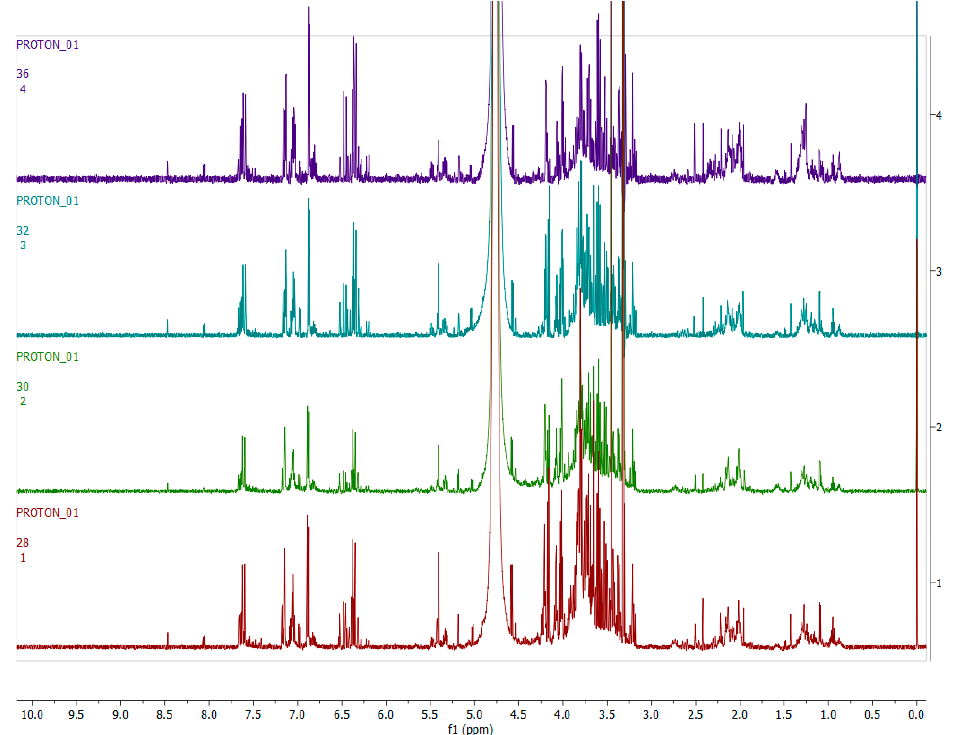
Figure 11. The 600 MHz 1 H-NMR spectra of H. aureonitens leaf extracts collected from the wet and dry sites at Wakefield during autumn season. Red = site 1 (wet); green = site 2 (wet); blue = site 3 (dry); purple = site 4 (dry).